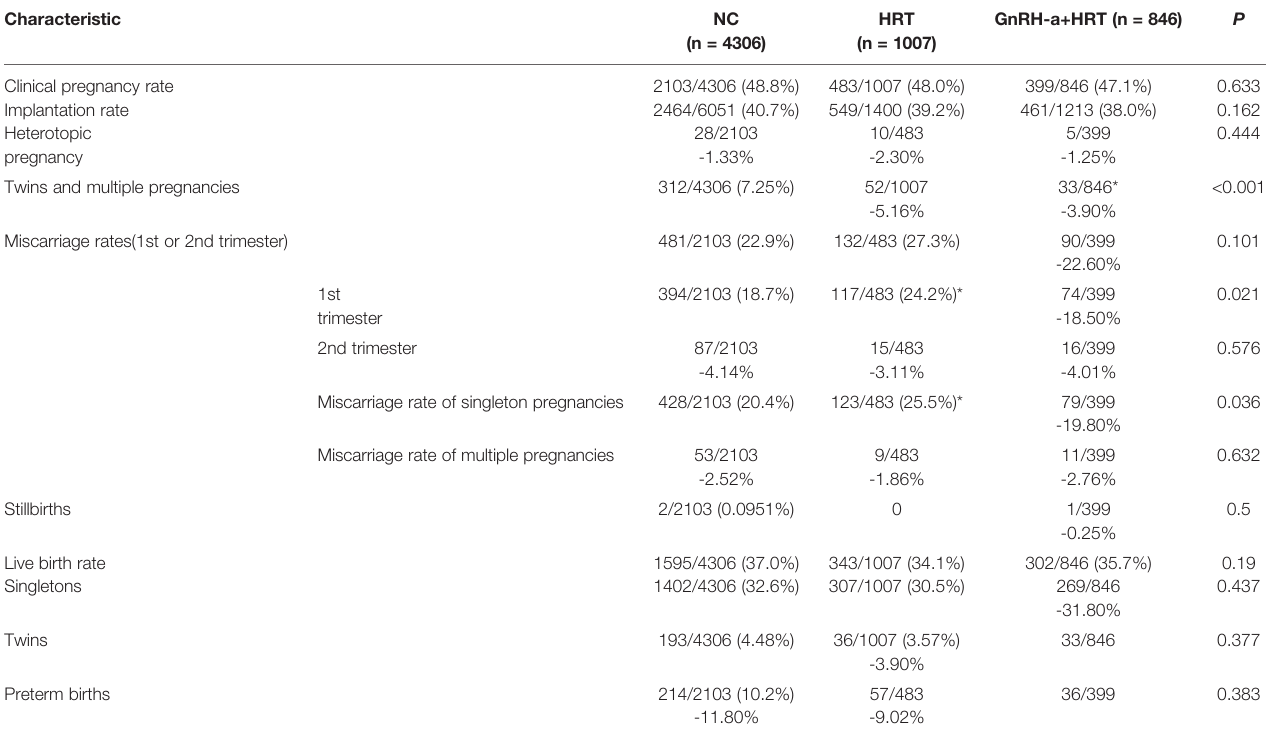
TABLE 3 | Reproductive outcomes per embryo